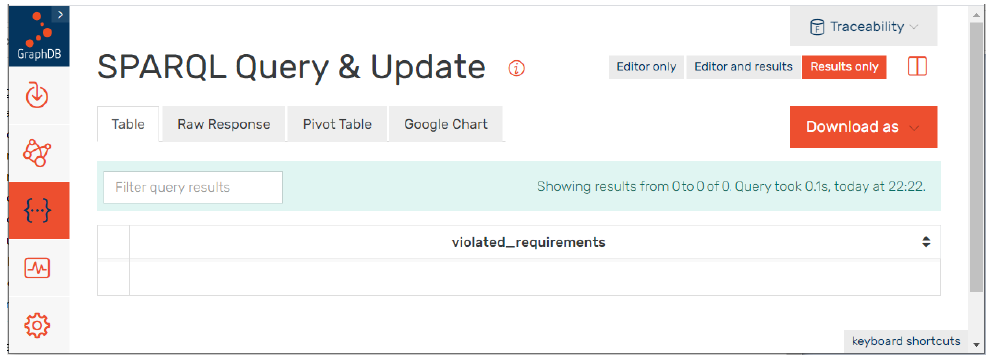
Figure 11. List of violated